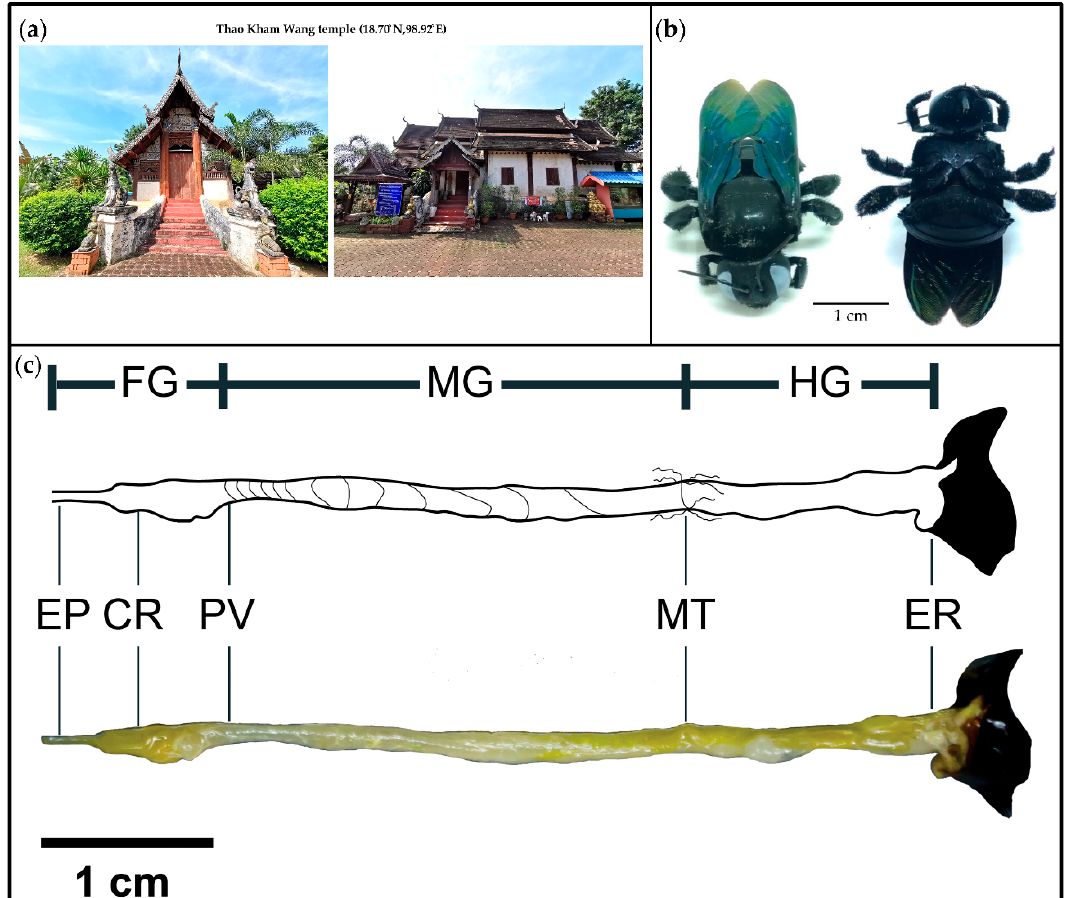
Figure 1. The old wooden church in Thao Kham Wang temple where carpenter bees live ( a ), carpenter bees that were collected from the church ( b ) and three sections of a carpenter bee’s intestinal